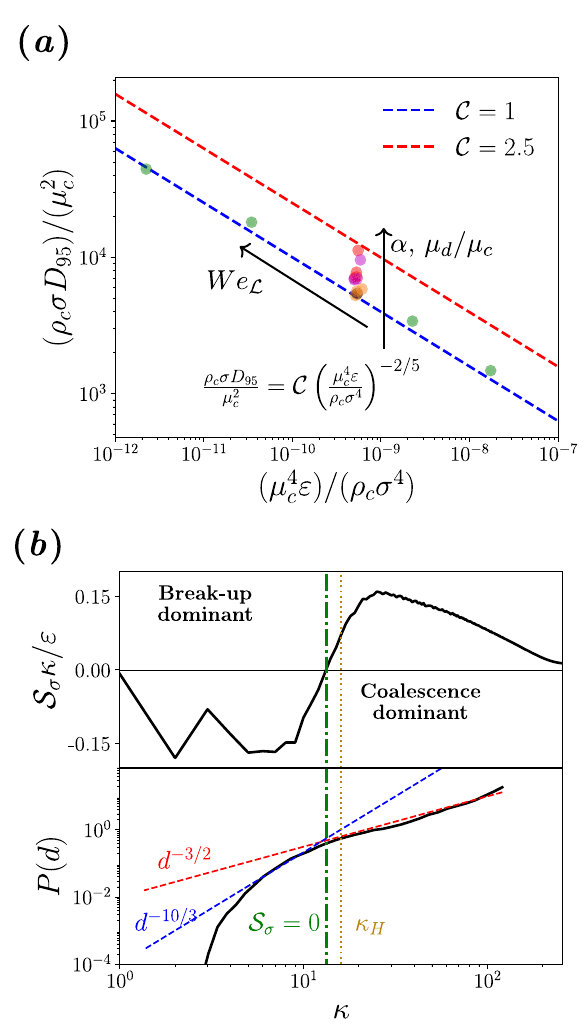
Fig. 2 The de fi nition of the Kolmogorov-Hinze scale. a Maximum droplet diameter D 95 as a function of the energy input ε , normalized as in ref. 19 . We performed several simulations, varying one parameter (i.e. , α , μ d / μ c and We α (red dots) at We = 42.6 L ) at the time. We show results for different L and μ d / μ c = 1; different We L (green dots) at μ d / μ c = 1 and α = 0.03; different μ d / μ c (purple dots) at α = 0.1 and We L = 42.6, and different μ d / μ c (yellow dots) at α = 0.03 and We L = 42.6. The arrows indicate data obtained with increasing values of each parameter. The blue line shows C ¼ We = 2 (cid:6) (cid:7) 3 = 5 ¼ 1, whereas C ¼ 0 : 765 was originally proposed 19 . b The c relationship between surface tension energy transfer and droplet-size- distribution. Top panel shows the term S σ from Eq. (2), normalized by the average energy dissipation and multiplied by κ to increase visibility. The bottom panel shows the droplet-size-distribution P ( d ), versus the wavenumber κ = 2 π / d . The vertical lines show S σ ¼ 0 ; (green-dashed) and the Hinze scale wavenumber computed using C ¼ 1